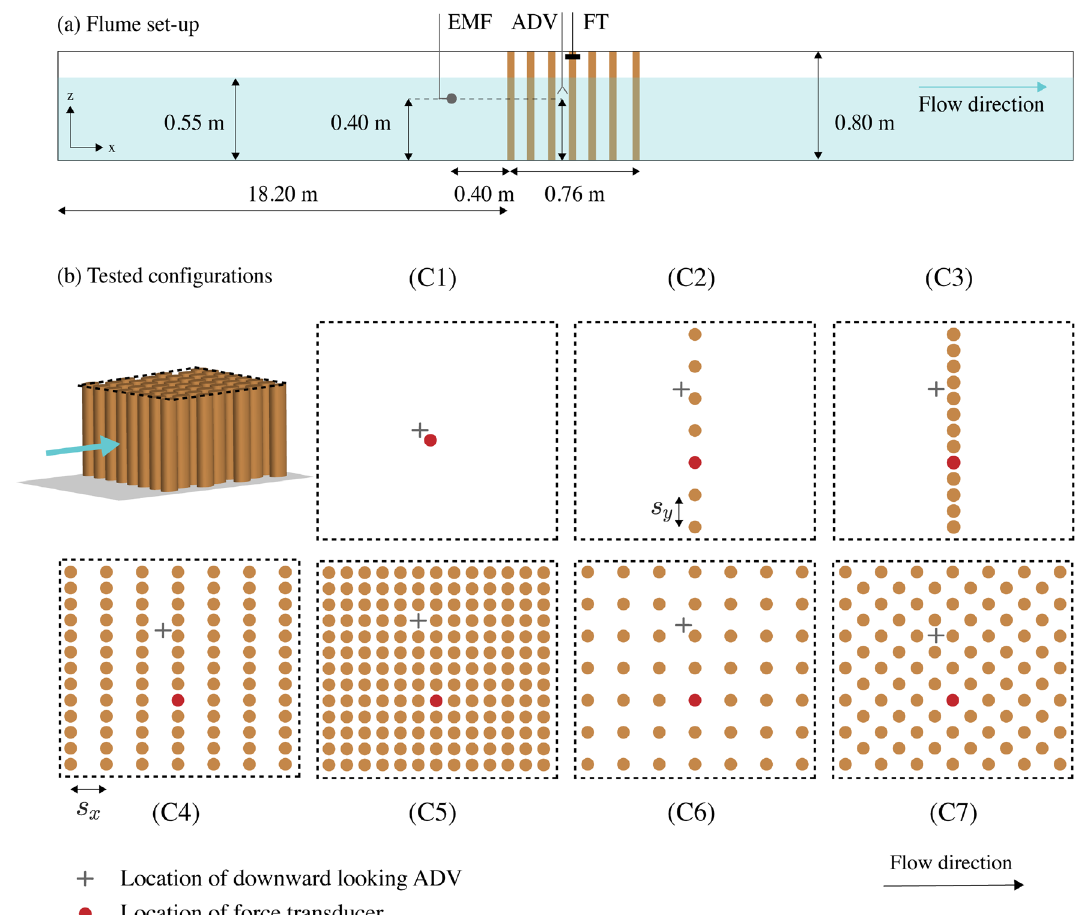
Figure 7. ( a ) Side view of the instrument set-up in the flume, consisting of an electromagnetic flow meter (EMF), a Nortek Vectrino acoustic velocimeter (ADV) and a SCAIME load cell mounted on the upper part of the element (FT). ( b ) Configurations tested in the experiments. An oblique view of the structure is shown at the top left side of the plot, where the flow direction is indicated by a blue arrow. The top view of the structure is marked by a dashed black line, and it is illustrated for each of the tested arrangements: (C1) single cylinder 3 d , (C3) single row with d 0.04 m, (C2) single row with spanwise spacing between the elements of s y = = 3 d in 1.5 d , (C4) multiple rows with s 1.5 d and s with spanwise spacing between the elements of s y x = y = = 1.5 d in uniform arrangement, (C6) multiple 1.5 d and s uniform arrangement, (C5) multiple rows with s y x = = 3 d in uniform arrangement, and (C7) multiple rows with s 3 d in 3 d and s 3 d and s rows with s y x = x = y = = staggered